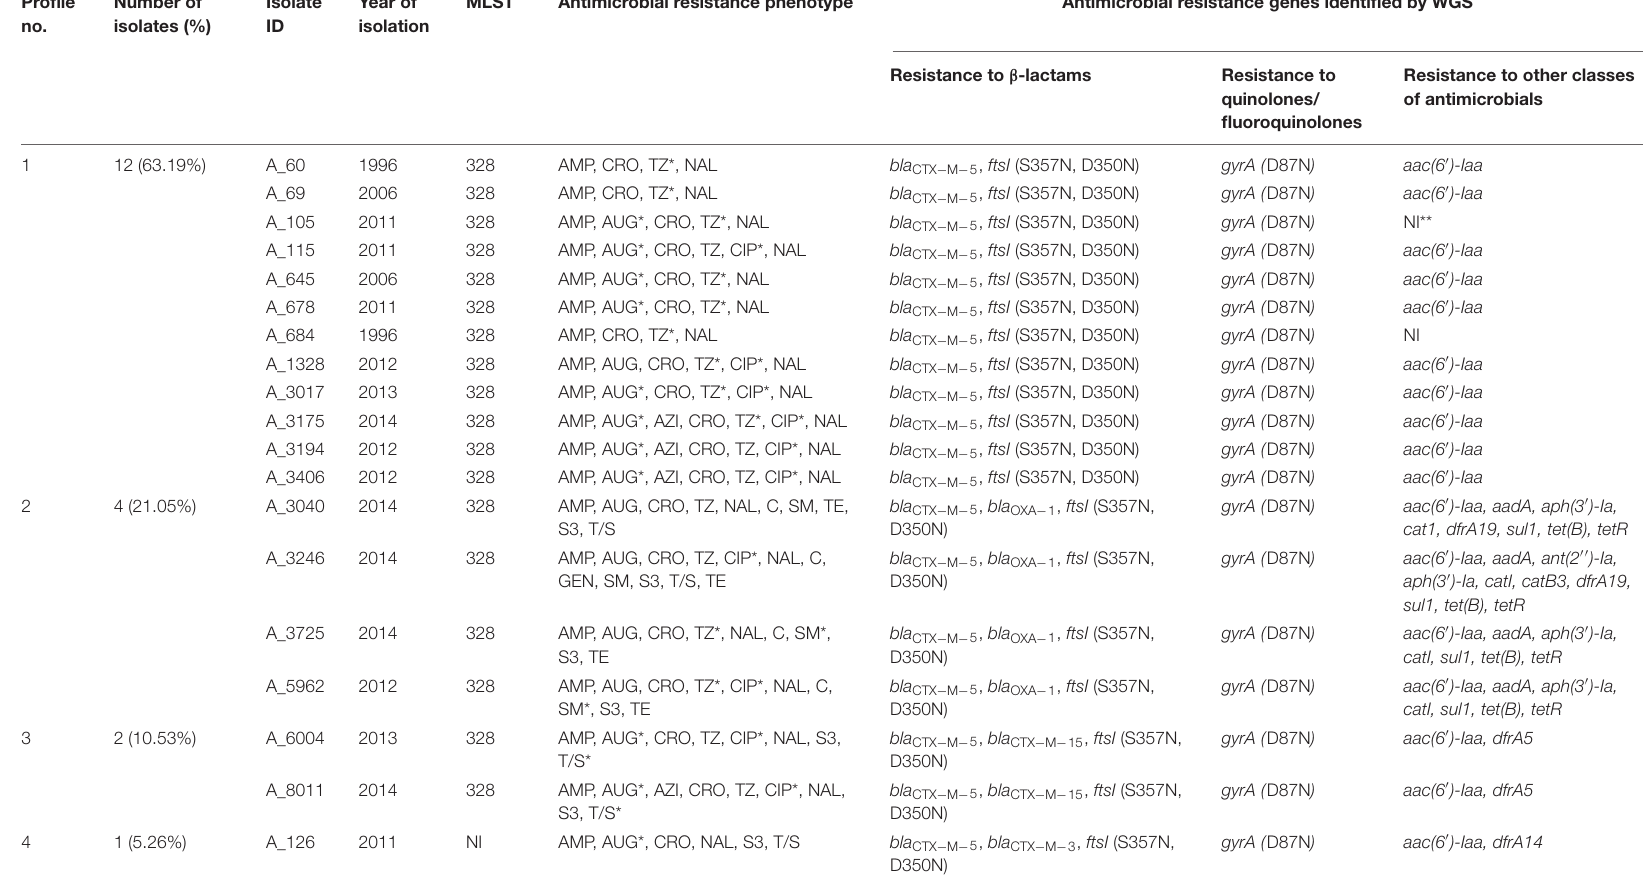
ESBL, extended-spectrum beta-lactamase; MDR, multidrug-resistant; NTS, non-typhoidal Salmonella; MLST, multi locus sequence type; WGS, whole genome sequencing; AMP, ampicillin; AUG, amoxicillin-clavulanic acid; AZI, azithromycin; C, chloramphenicol; CIP, ciprofloxacin; CRO, ceftriaxone; TZ, ceftazidime; IMI, imipenem; NAL, nalidixic acid; SM, streptomycin; TE, tetracycline; T/S, trimethoprim-sulfamethoxazole; S3, sulfonamides. *Intermediate susceptibility to antimicrobial agent. **Not identified